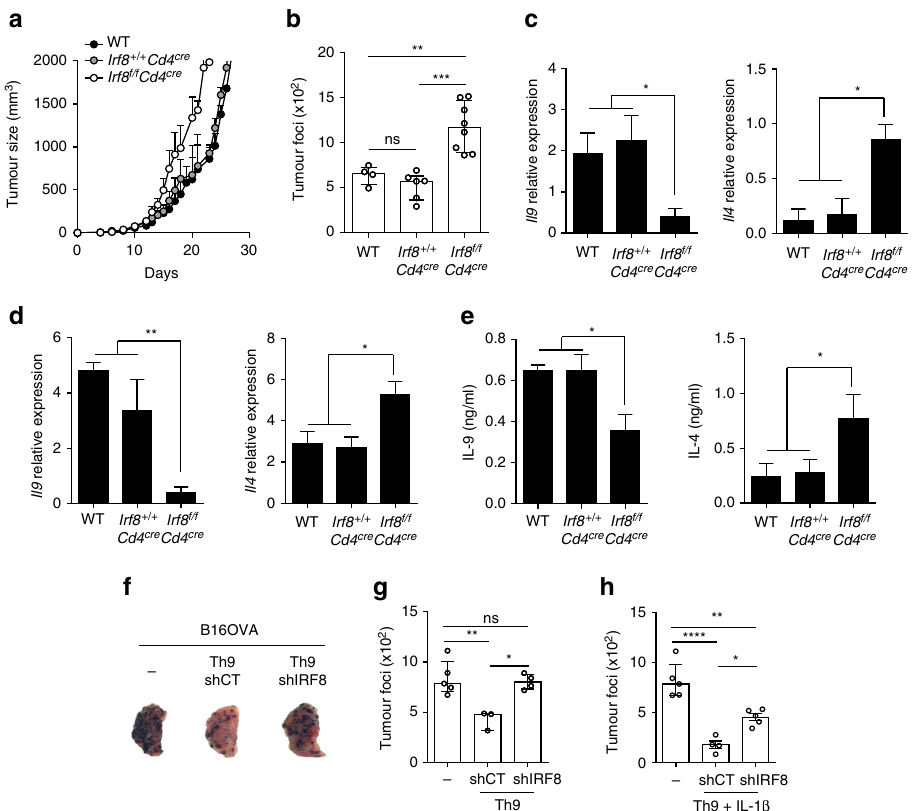
Fig. 6 IRF8 is required for anti-tumour effect of Th9 cells. a WT, Irf8 f/f Cd4 cre and Irf8 + / + Cd4 cre mice were subcutaneously (s.c.) injected with B16F10 cells and tumour growth was monitored. Representative data from one of three experiments are shown (mean and s.e.m., 10 mice per group). b WT, Irf8 f/f Cd4 cre and Irf8 + / + Cd4 cre mice were intravenously (i.v.) injected with B16F10 melanoma cells and 12 days later mean numbers of lung tumour foci are shown (mean and s.e.m., 5 mice per group, 3 independent experiments). c Il4 and Il9 mRNA expression analysis in tumour in fi ltrated lymphocytes (TILs). d , e Tumour-draining lymph nodes (TDLN) from WT, Irf8 f/f Cd4 cre and Irf8 + / + Cd4 cre mice given a subcutaneous injection of B16F10 cells were collected at day 13. Analysis of Il4 and Il9 mRNA expression in TDLN ( d ). TDLN cells were stimulated for 72 h in plate-bound anti-CD3 and anti-CD28, and IL-4 and IL-9 release was assessed by ELISA ( e ). f – h WT mice were injected iv with B16F-OVA melanoma cells or together with effector OT-II Th9 ( f , g ) or OT-II Th9 + IL-1 β ( h ) cells infected with shRNA control (shCT) or against Irf8 (shIRF8). Representative lung from mice untreated or treated with Th9 cells infected with shCT or shIRF8, 13 days after intravenous injection ( f ). Mean numbers of lung tumour foci are shown ( g , h ) (mean and s.e.m., 5 mice per group, 3 independent experiments) ns, not signi fi cant; * P < 0.05, ** P < 0.01; *** P < 0.001 (Kruskal – Wallis test ( b – e , g , h ))